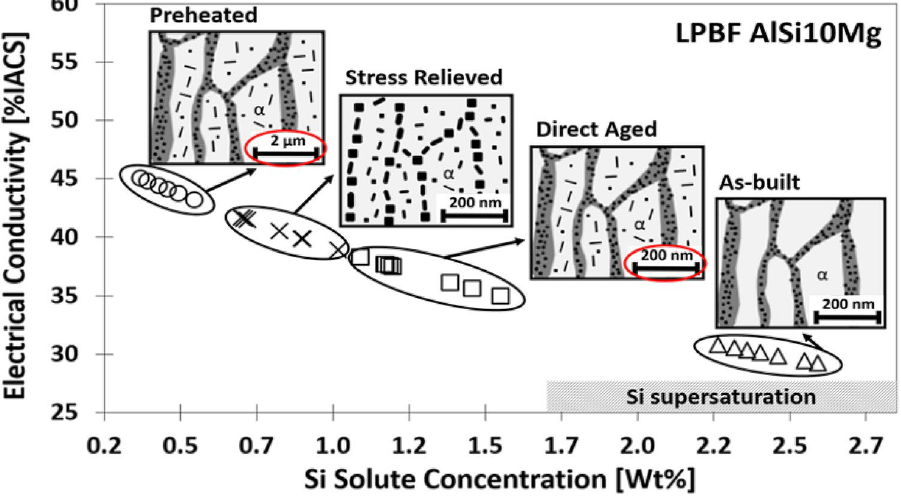
Figure 10. LPBF-processed AlSi10Mg: Schematic microstructural evolution upon heat treatment and its correlation with the predicted Si solute concentration in the Al matrix as a function of the electrical